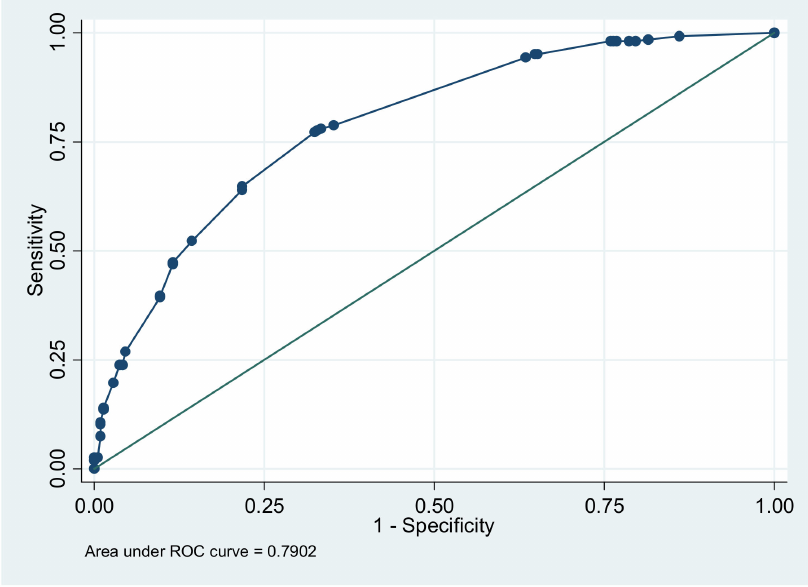
Figure 1. Area under the receiver operating characteristic curve (AUC) for the risk score